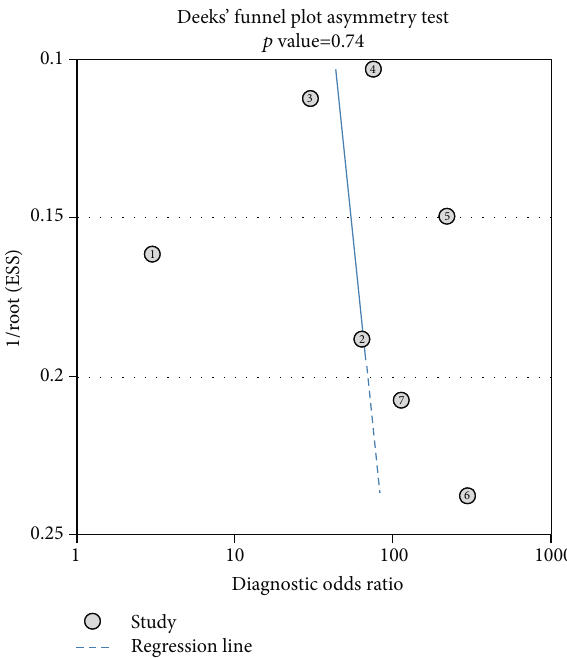
Figure 5: Funnel plot based on the data of PET/CT for the diagnosis of recurrent pancreatic